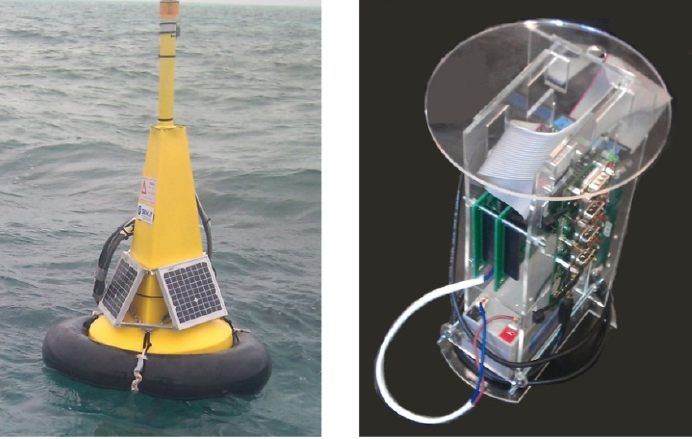
Figure 17. The SEMAT Mk3 prototype buoy deployed at Heron Island ( left ) and the internal electronics ( right